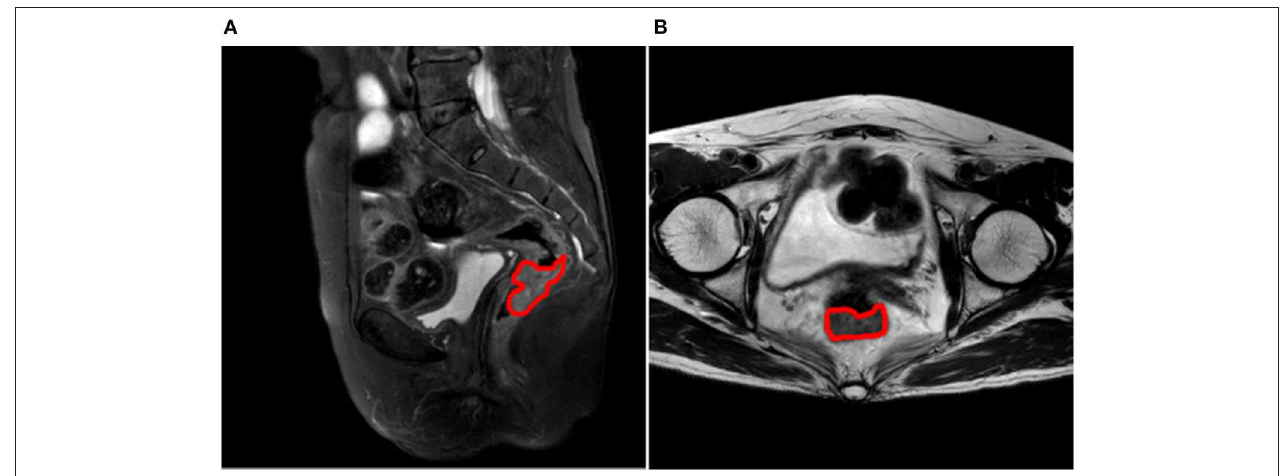
FIGURE 2 | (A) Lesion segmentation result on sagittal fat-suppression T2WI, the margin of the lesion is marked in red; (B) Lesion segmentation result on oblique axial T2WI, the margin of the lesion is marked in red.